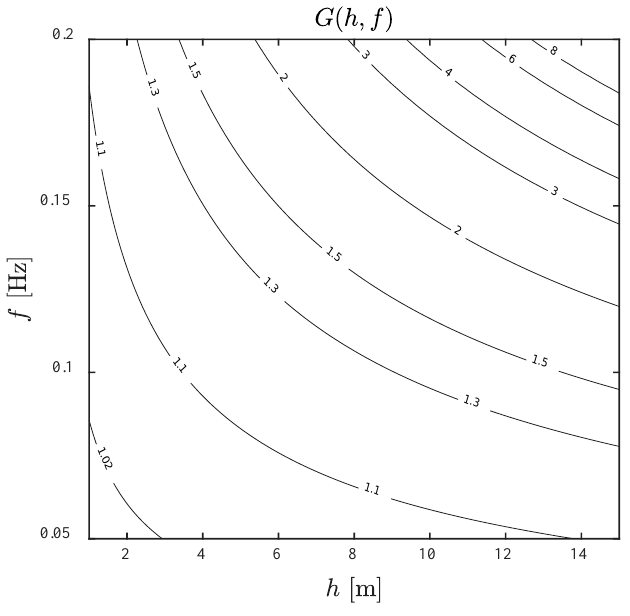
Figure 5. The parameter G as a function of water depth and wave frequency.